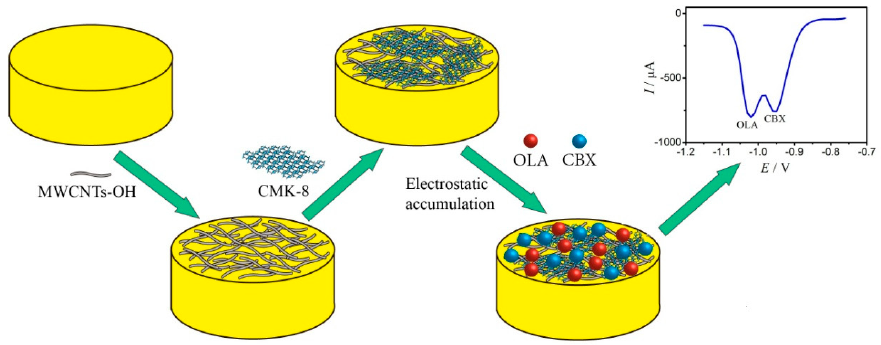
Figure 7. The schematic of the MWCNTs − OH / CMK − 8 / GE modified electrode’s fabrication and the detection of OLA and CBX.